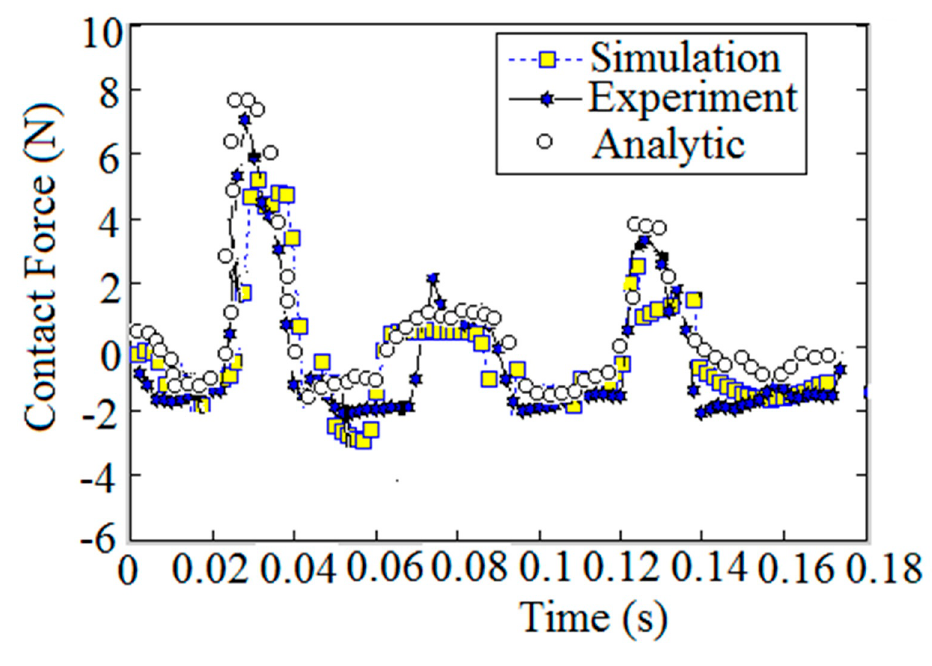
Figure 13. Contact force against time.